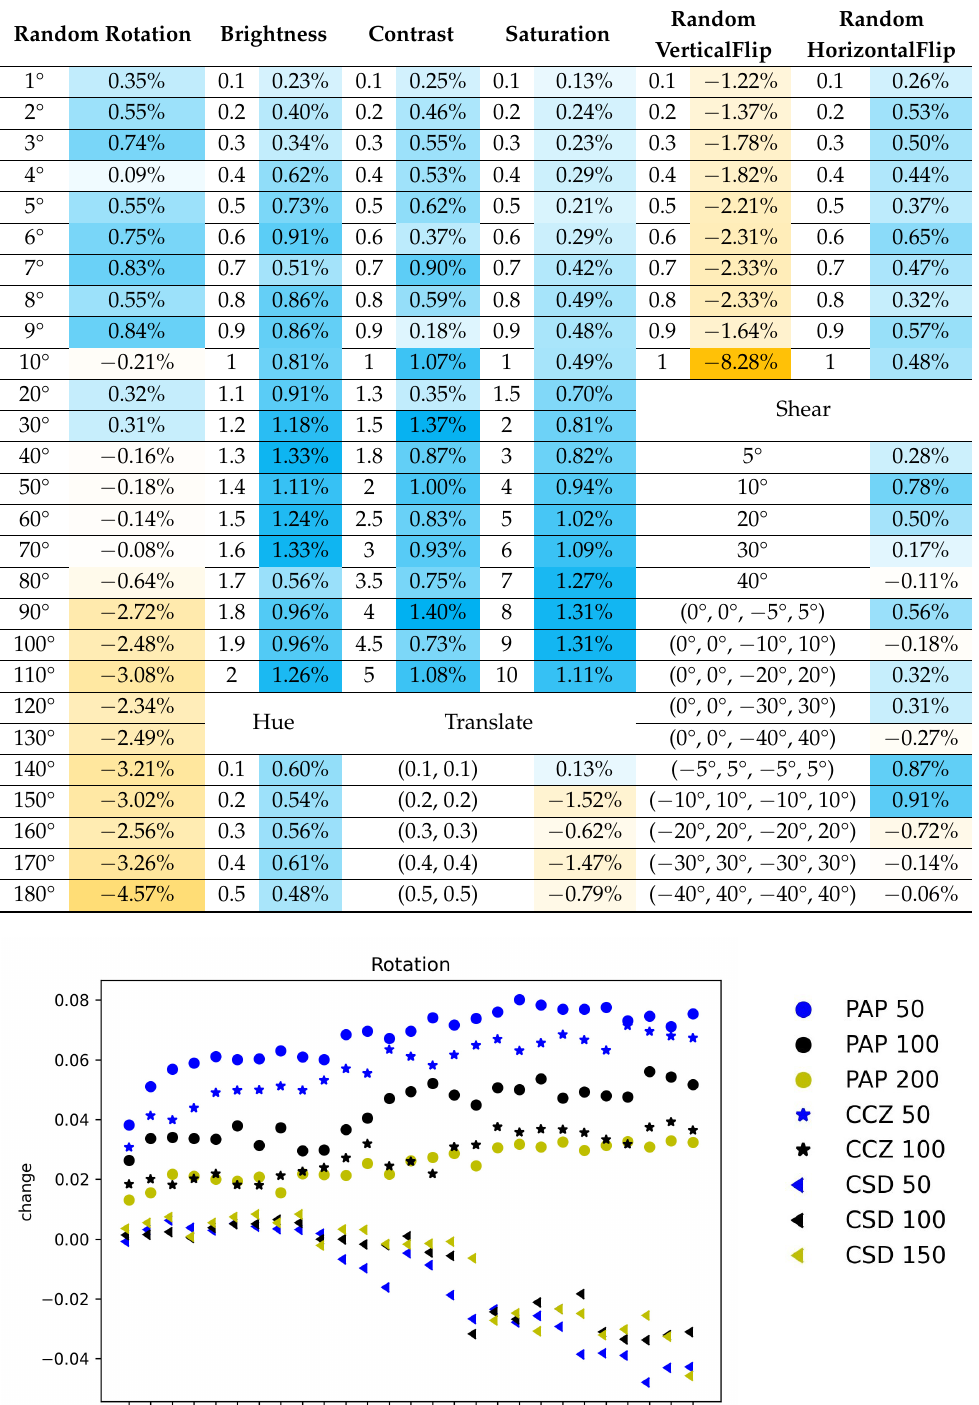
Table 9. Performance of DA methods on Γ train 150 . The heatmap shows the DA methods and param- CSD eters impact on Γ train 150 classification performance. The displayed percentage values describe the CSD increase/decrease of mAA in percent. The value is color-coded from blue (increase in accuracy) over white (no effect) to orange (decrease in accuracy).